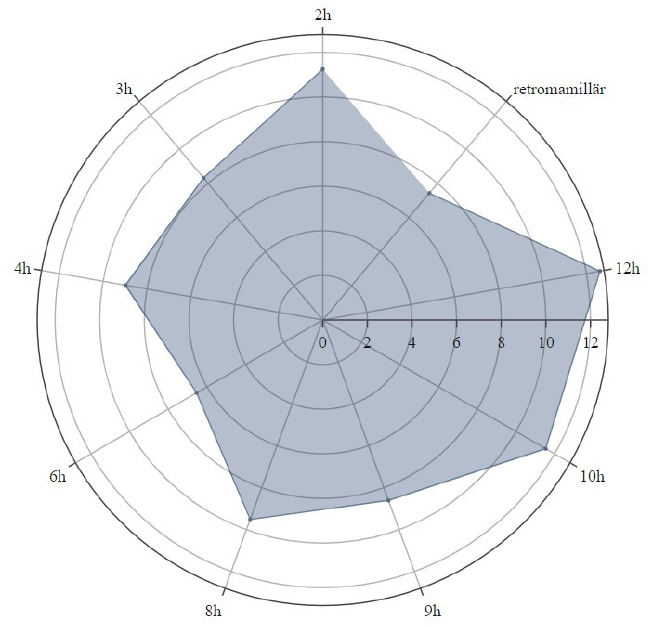
Figure 6. Skin flap measurements. Mean values of the skin flap diameters.